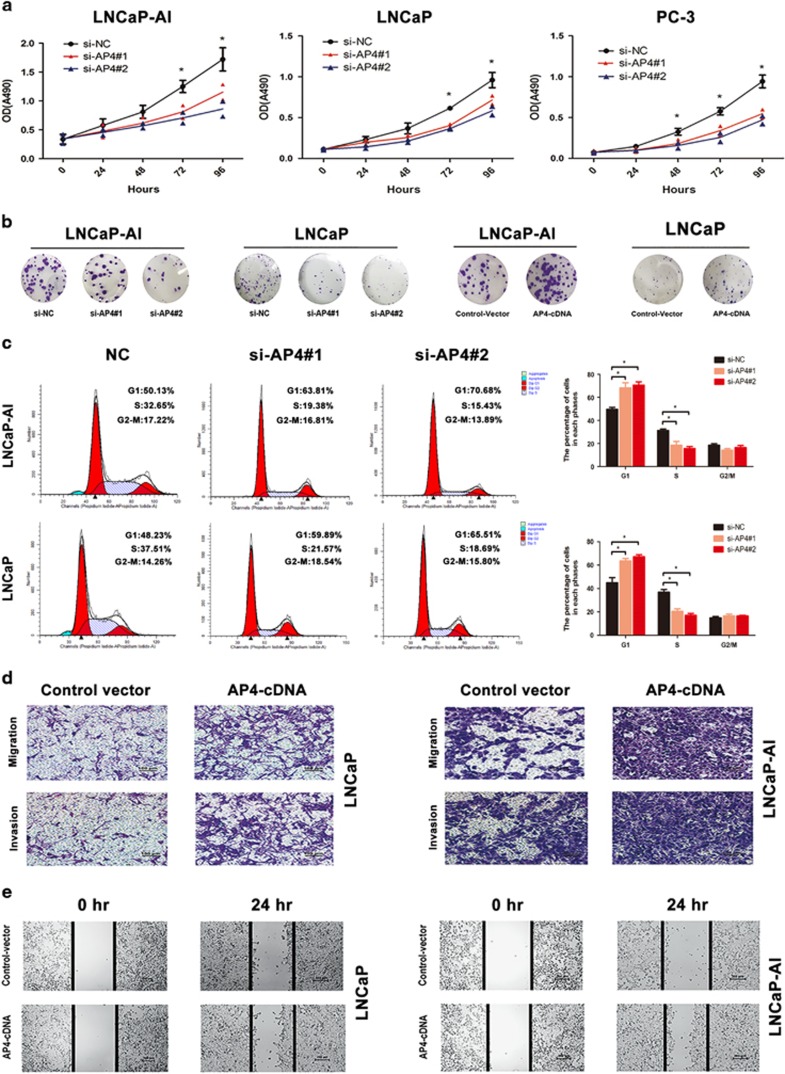
AP4 increases the proliferation, migration and invasion of PCa cells in vitro. (a) AP4 knockdown decreased the proliferation as determined by MTT assay. (b) Effect of AP4 knockdown or overexpression on colony formation was measured in LNCaP and LNCaP-AI cells. Representative images of the colonies, stained with crystal violet. (c) LNCaP and LNCaP-AI were transfected with si-AP4#1 or si-AP4#2 and analyzed by flow cytometry. Percentages of cell populations at different stages of cell cycles are listed within the panels. (d) The motility of PCa cells transfected with AP4-cDNA when compared with the controls by the wound healing assay. (e) The migration and invasion of PCa cells were transfected with AP4-cDNA compared with NC by transwell assays. Values represented the mean±S.D. from three independent experiments. *P<0.05, **P<0.01